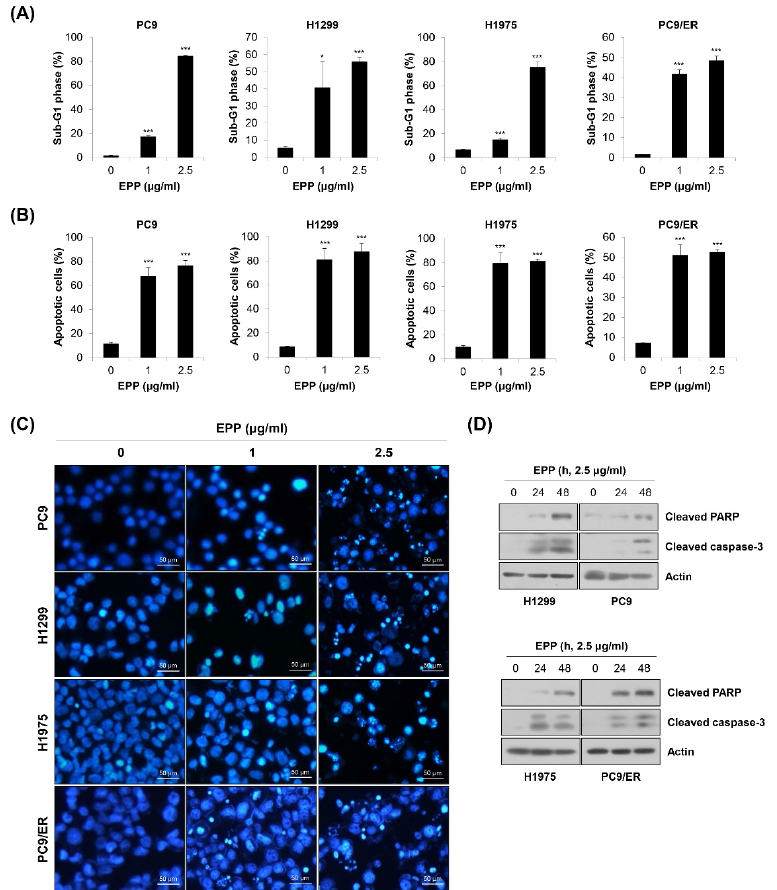
Figure 3. Induction of apoptosis by EPP in human NSCLC cell lines with different EGFR